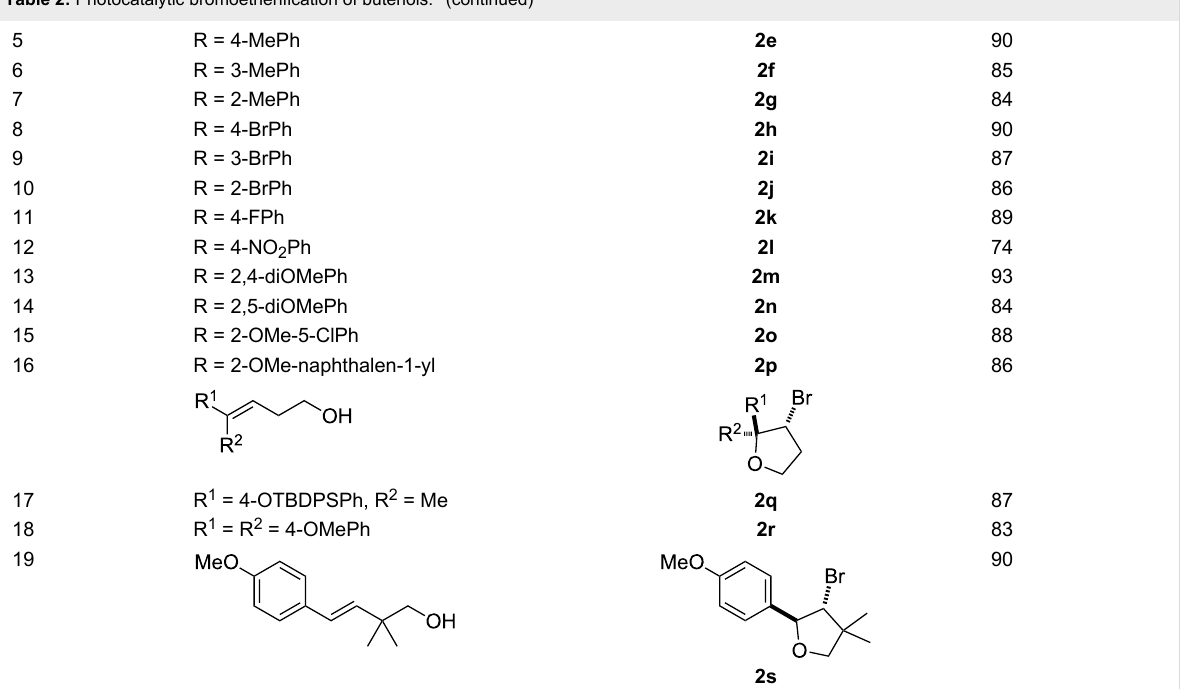
Table 2: Photocatalytic bromoetherification of butenols. a (continued)